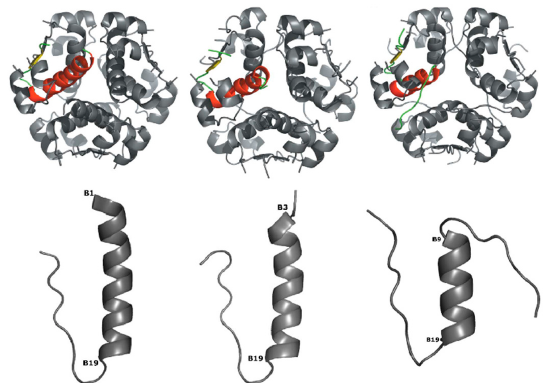
Figure 9. Upper part: The three configurations of insulin in the hexameric configuration (from left to right): R 6, T 3 R 3f and T 6 . The configuration of B-chain N-terminus is illustrated in red in one of the monomers of each hexamer, which differentiates the three forms. Lower part: Isolated view of the configuration of the B-chain N-terminus in each of the three forms respectively [122,123]. The interconversion among the three conformations is mediated by ligand-binding in allosteric sites with the most important among them being the hydrophobic pockets (3 in T 3 R 3f and 6 in R 6 ), which bind phenol-like ligands [99,124]. In the absence of allosteric ligands, insulin hexamers adopt the T 6 conformation. The T 3 R 3 f conformation can be induced by thiocyanate anions [125] while T 3 R 3 f and R 6 conformations are induced and further stabilized by the binding of phenol and its derivatives to the abovementioned hydrophobic pockets (phenolic pockets) [122,126,127]. The three conformations display different biochemical stability in the following, descending order: R 6 > T 3 R 3f > T 6 [128]. Furthermore, it is examined whether a single microcrystalline pharmaceutical formulation could contain two active components, via the co-crystallization of HI with selected organic molecules of proven pharmacological importance, providing better regulation of insulin release which will be combined with the availability and the mode of action of the co-crystallized molecule. It is evident that insulin is distinguished for its polymorphism at both the molecular and crystal levels. A combination of both types of polymorphic characteristics may lead to products with improved features. Thus, identification of these polymorphs must be performed in the polycrystalline sample which should be examined as unity. XRPD is the optimum research tool that makes this type of study feasible. Early attempts were made by Norrman and his colleagues in 2006 [122], but data quality only allowed for the extraction of limited structural information via data clustering based on their similarities and principal component analysis [129]. XRPD patterns of each cluster can, however, be used as “fingerprints” for the different insulin polymorphs. In the following years, improvements in instrumentation led to enhanced data resolution maximizing the extracted structural information. External insulin is provided subcutaneously via injections obviating its degradation by gastric enzymes, while research aiming toward administration of HI in the form of a pill or inhalation is still proceeding [130–133]. 3.2. Distinct and Novel HI Polymorphs Identified via XRPD Depending on pH and ion concentration upon crystallization, the conformation of HI shifts between different molecular and crystal polymorphs. In “ligand-free” samples, in cases when pH ranges from 5 to 6.5, the rhombohedral symmetry (T 6 molecular conformation) of HI (space group: R 3, a = 82.99 Å, c = 34.07 Å) has been identified, while in pH range from 6.9 to 7.5, the T 6 alters to T 3 R 3f ( a = 80.66 Å, c = 37.74 Å), a transition which is evidently depicted in peak position changes (Figure 10).